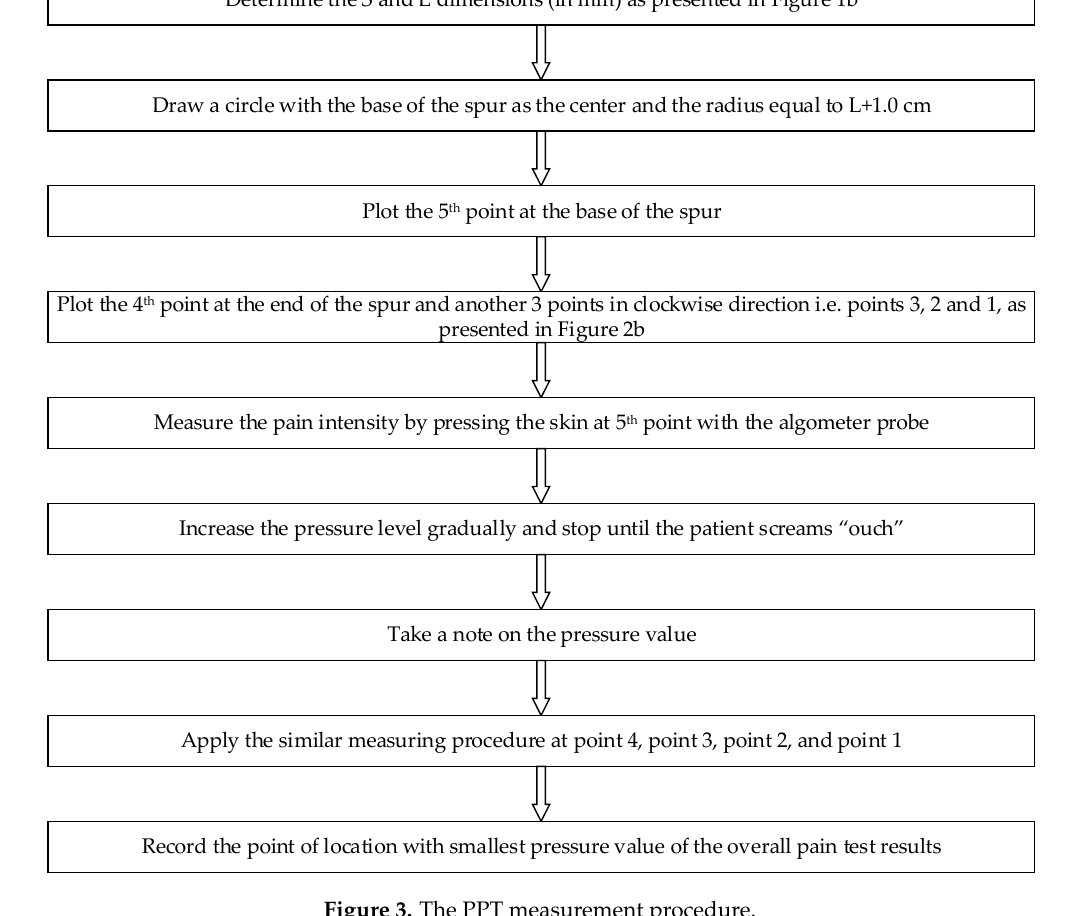
Figure 3. The PPT measurement procedure.